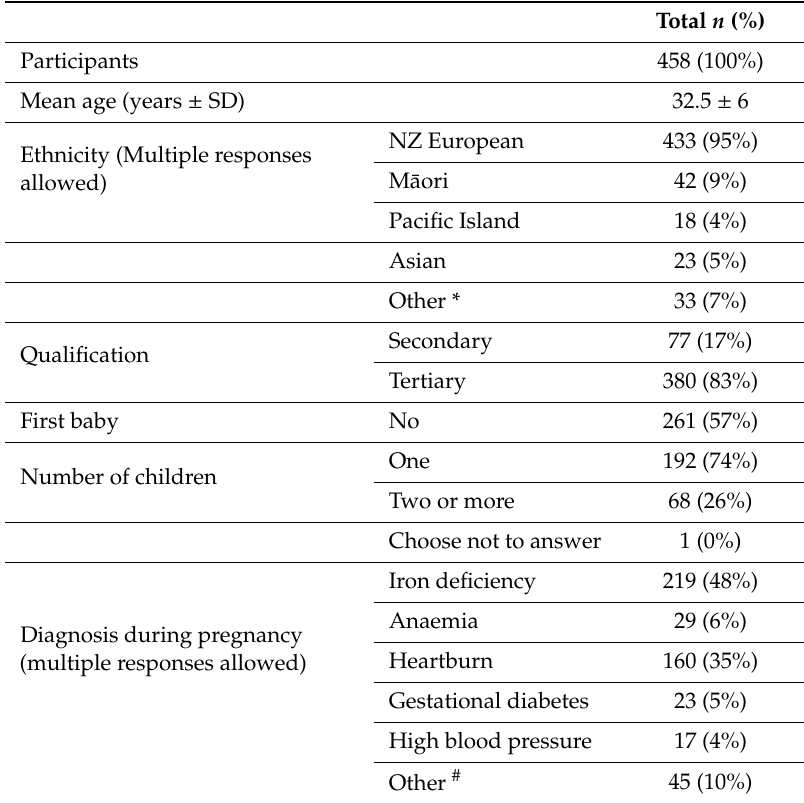
Table 1. Participant